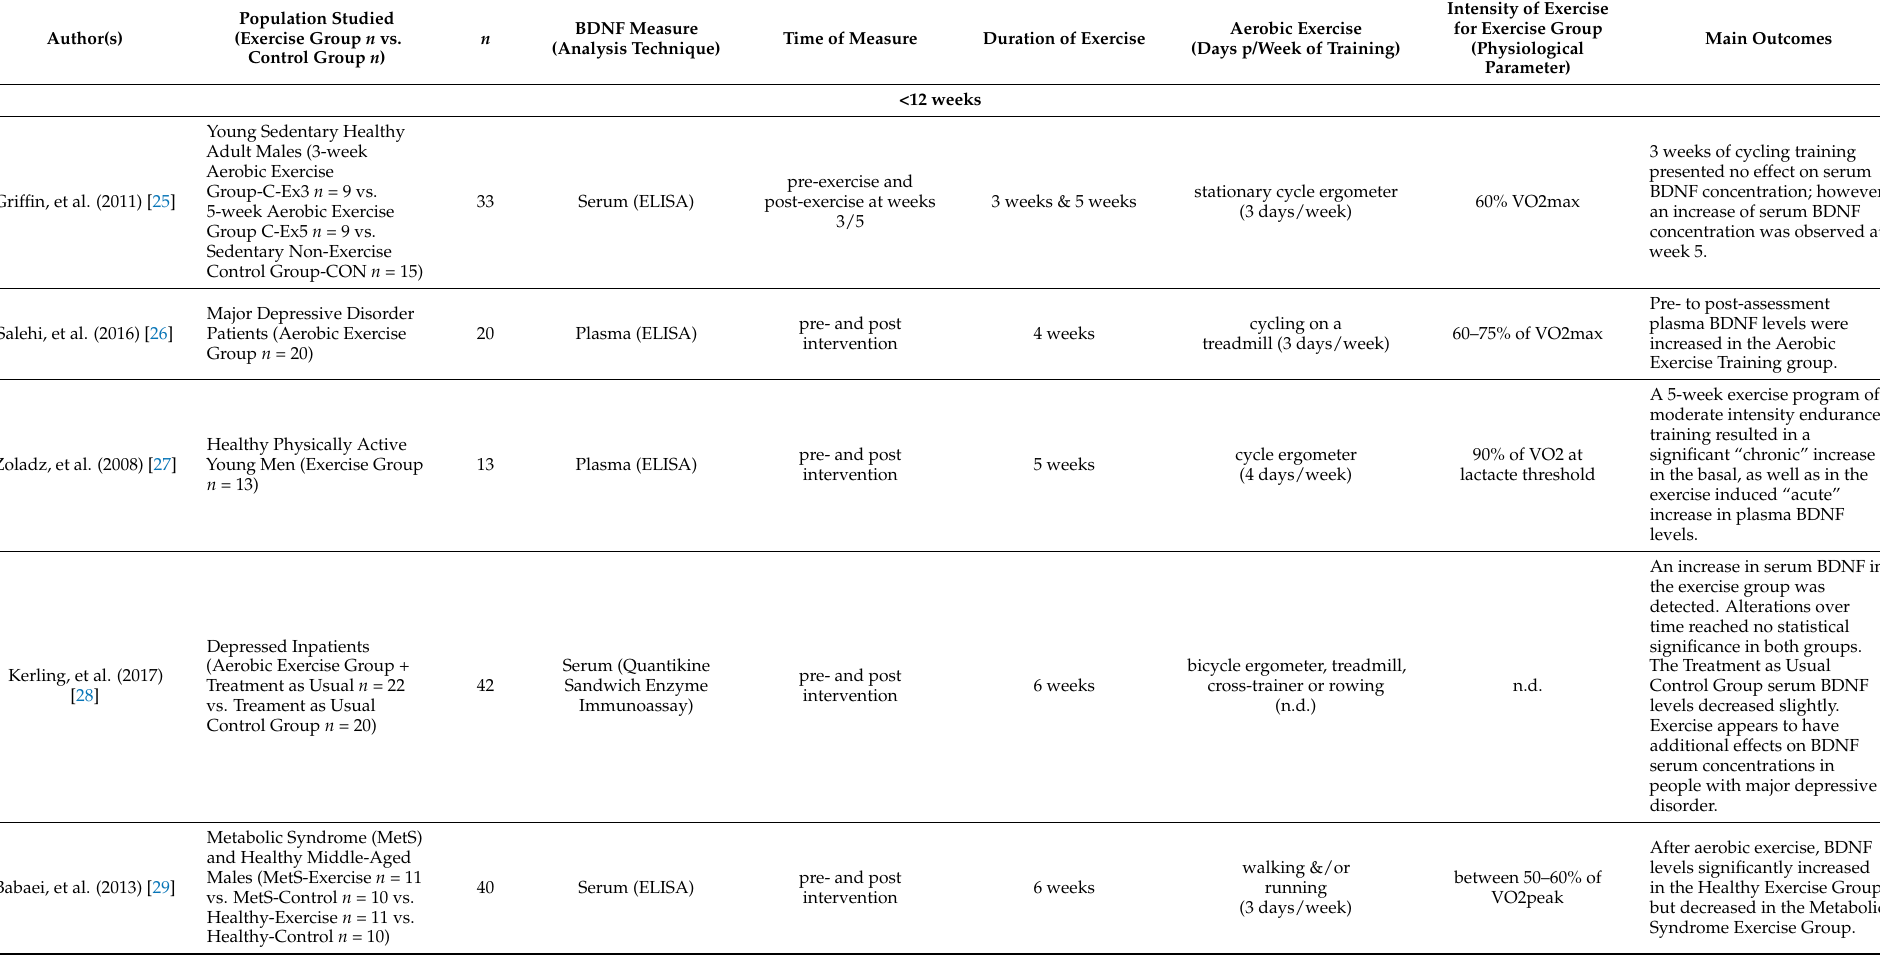
Table 1. Summary of studies that have reviewed the relationship between a chronic aerobic exercise intervention and the variation of BDNF blood concentration levels in human